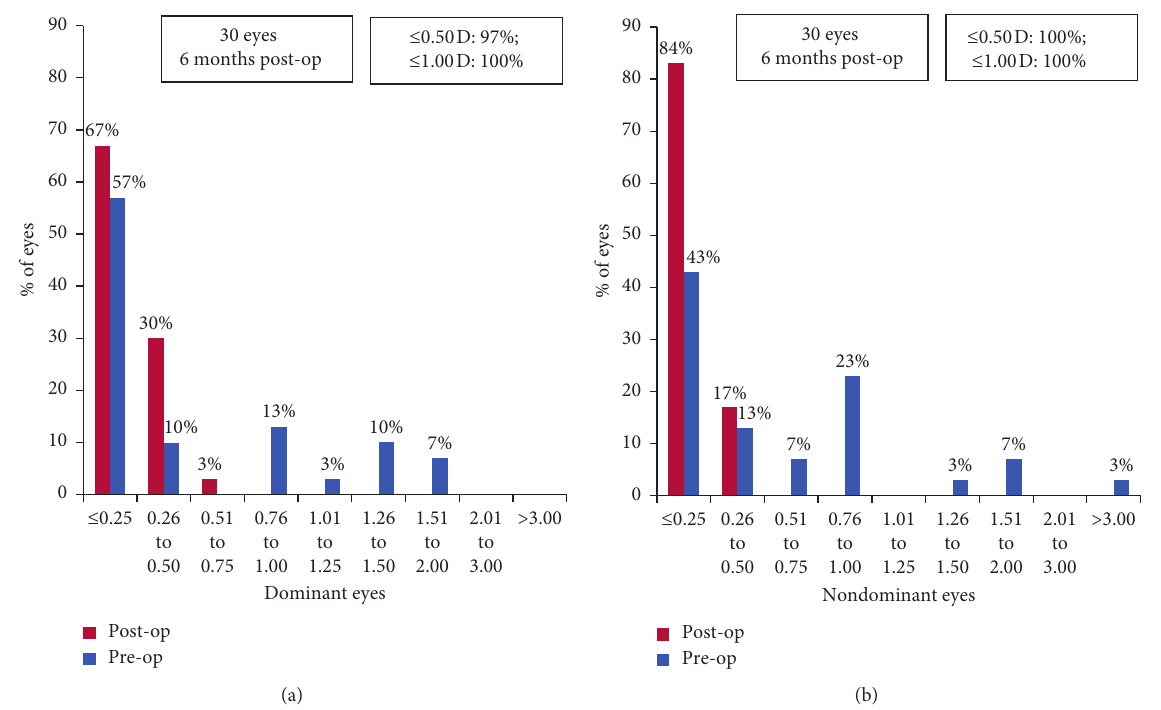
Figure 4: Histogram showing change in refractive astigmatism for (a) dominant and (b) nondominant eyes at 6 months